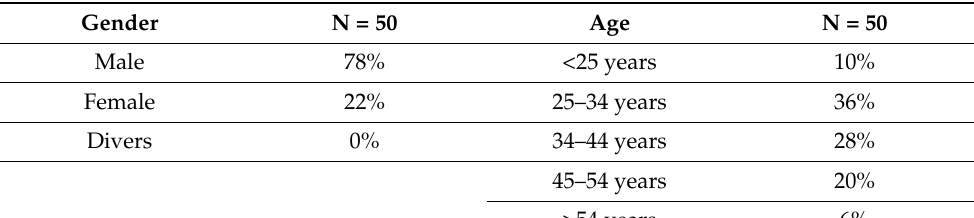
Table 8. Evaluation of demographic data.—Gender and Age.